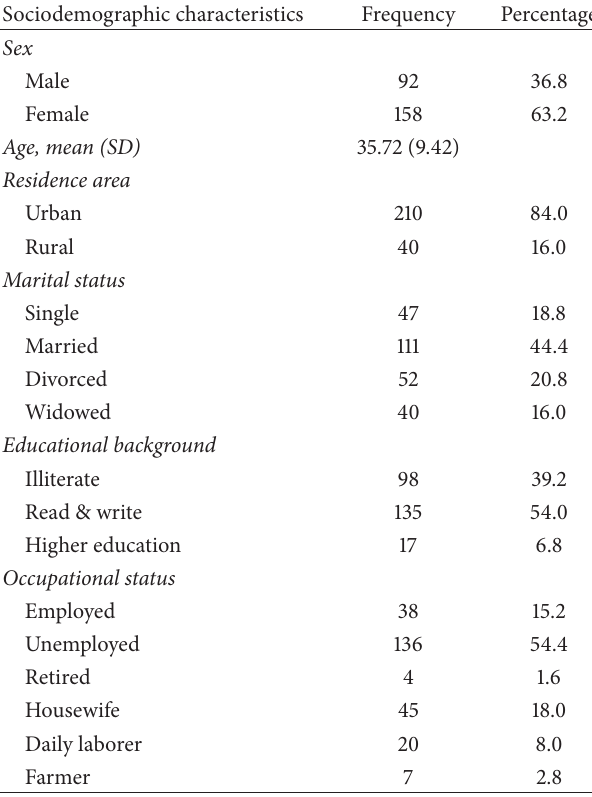
Table 1: Sociodemographic characteristic features of the study participants in Gondar, North West Ethiopia, 2012.